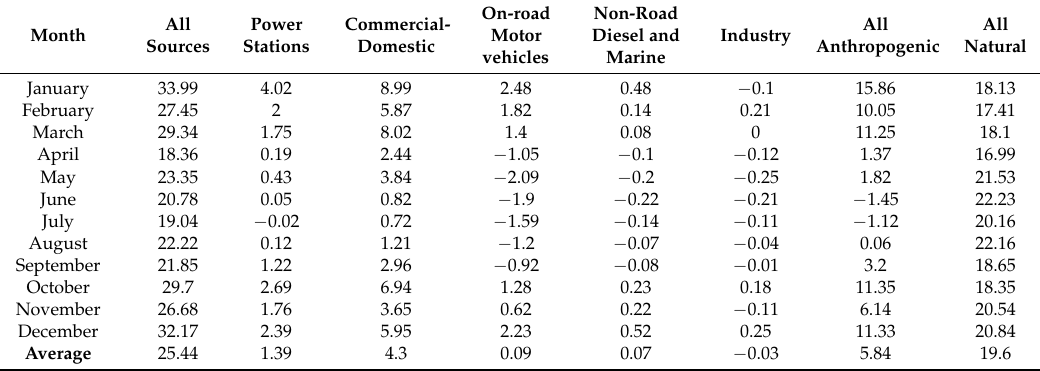
Table A4. Monthly average of daily maximum 1-hour predicted ozone concentration (ppb) in the Illawarra region for different months in 2008 under various emission scenarios.